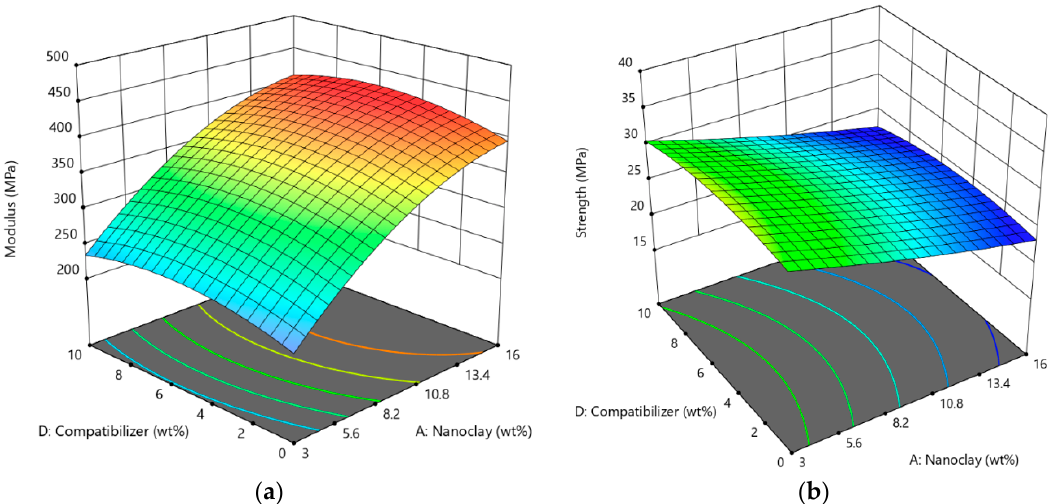
Figure 3. 3-Dimensional (3D) surface plot of ( a ) tensile modulus and ( b ) tensile strength versus compatibilizer and nanoclay fractions.